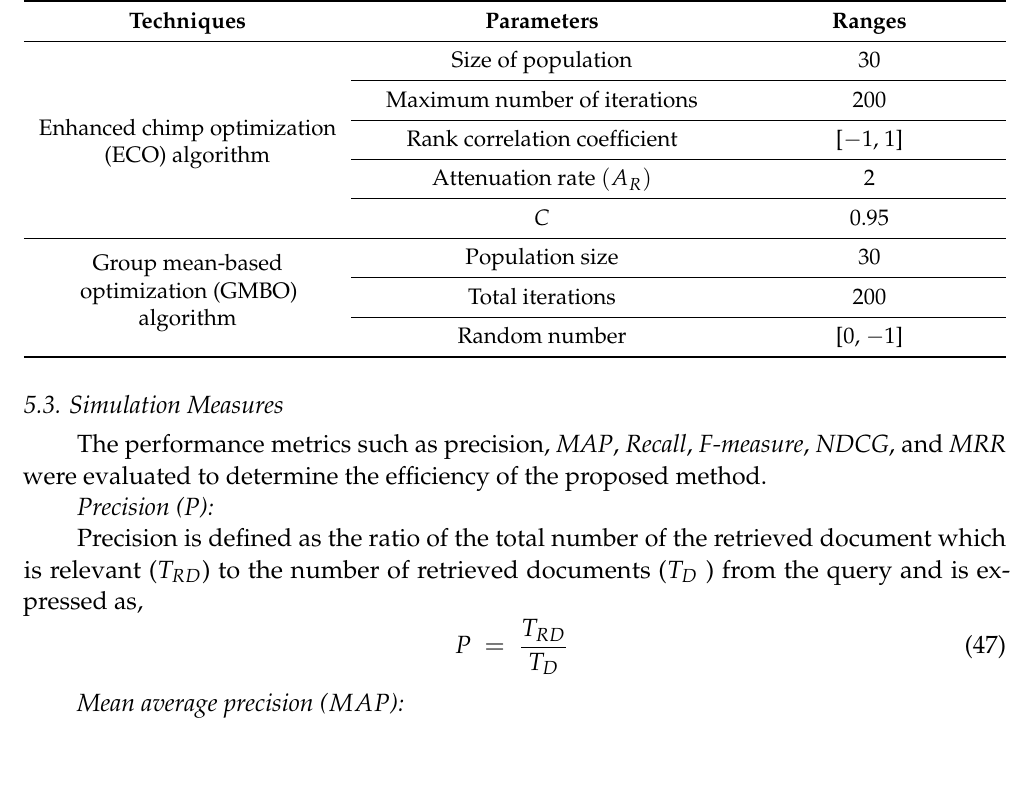
Table 2. Parameter settings for the proposed